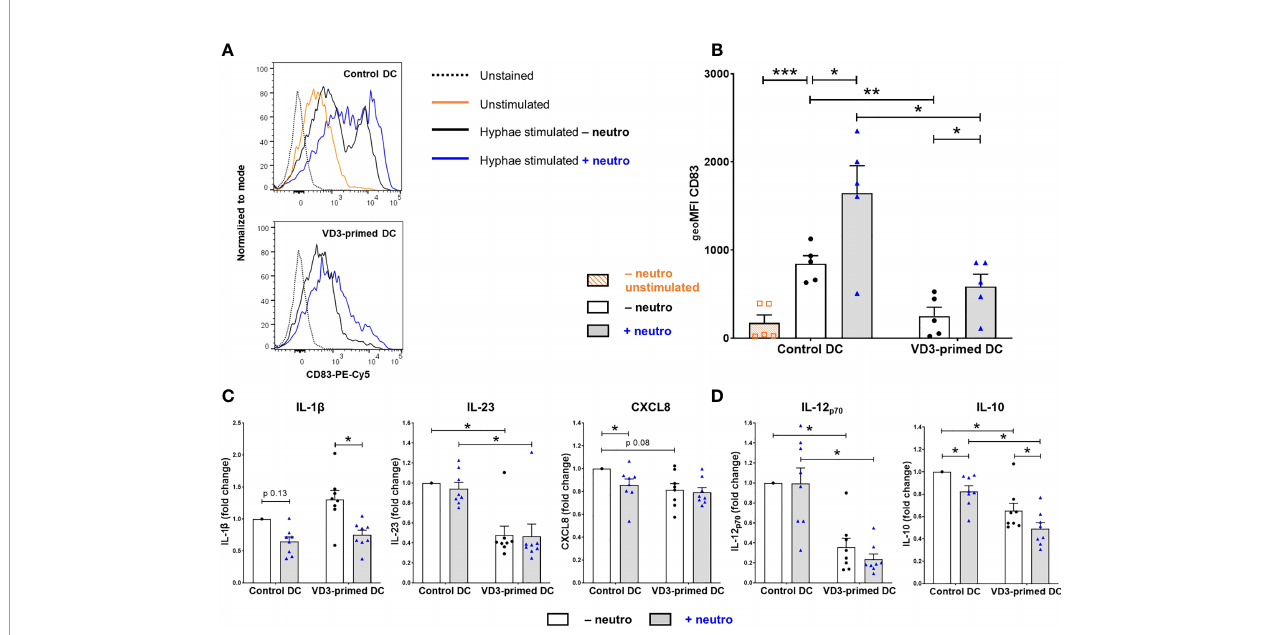
FIGURE 4 | DCs primed with VD3 show reduced CD83 expression and suppressed Th1/Th17-polarizing cytokine production. (A) CD83 expression on control or VD3-primed DCs is depicted, either unstimulated or matured with C. albicans hyphae in the presence or absence of neutrophils. Representative histograms are shown. (B) CD83 data are expressed as geometric mean fl uorescence intensity (geoMFI) of fi ve independent experiments (mean ± SEM). (C) Cytokine release by control or VD3-primed DCs stimulated with C. albicans hyphae and CD40 ligand-expressing cells. Fold change versus control DC conditions without neutrophils is shown ( n = 8, mean ± SEM). (D) IL-12 p70 and IL-10 secretion by control or VD3-primed DCs is shown in the absence or presence of neutrophils. One-way ANOVAs with Holm – Sidak ’ s post hoc test were performed in (B, D) , and Friedman tests with Dunn ’ s post hoc test in (C) . * p < 0.05, ** p < 0.01, *** p <